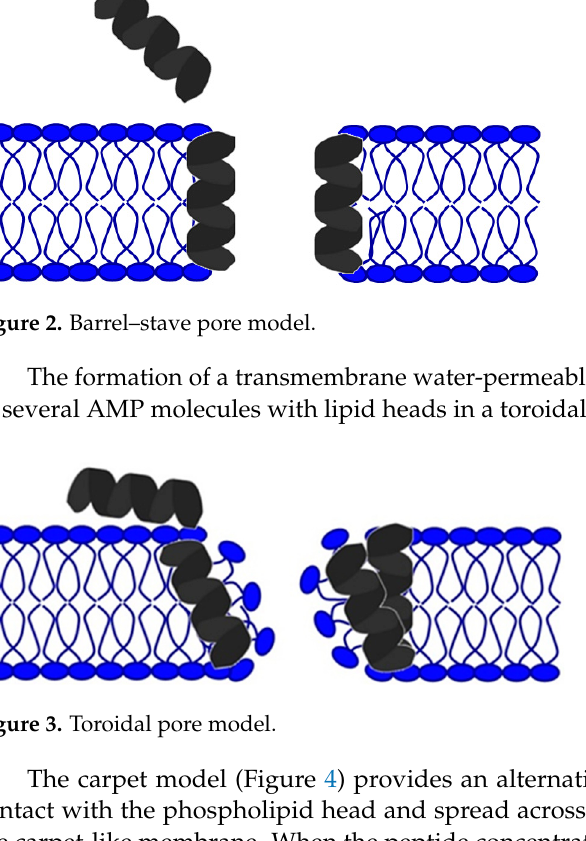
Figure 4. Carpet model. 3. Antimicrobial Effects of AMPs 3.1. Antibacterial Activity of AMPs As the primary goal in researching AMPs was the fight against (increasingly re- sistant) bacteria, some scientists emphasize this need and call them antibacterial peptides (ABP) [34,35]. They can destroy bacteria by breaking the cell wall and membrane of the bacteria, intracellular action, through a combination of dual destruction mechanisms, and by acting on the bacterial biofilm [36,37]. By binding to lipid II, which is part of the pepti- doglycan molecule and an essential factor in cell wall synthesis, ABPs prevent cell wall formation. In addition to controlling its assembly, it can destroy the already-formed cell wall [37–40]. Acting on the membrane is possible in several ways. The barrel-shaped and toroidal pore models can be defined as transmembrane pore models. Vertical insertion of the peptide into the membrane while promoting peptide–peptide lateral interaction is typ- ical of the barrel-shaped pore model [37,41,42]. In the toroidal pore model, peptides are also vertically embedded in the membrane. However, here the pores are created by both peptide and lipid groups. The most crucial difference between these two models is that the barrel model’s hydrophobic and hydrophilic bilayers remained intact [37,42,43]. The model that does not create pores through the membrane and in which specific peptide– peptide interactions are not necessary belongs to the so-called carpet model. It is charac- terized by adherence of ABP along the bacterial membrane and its adsorption until a par- ticular concentration is reached. After crossing the tolerance threshold, a detergent-like model appears, and a loss of integrity and opening of the bacterial membrane happens [13,37,43–45]. Many peptides work by destroying intracellular functions, and in that way, they kill bacteria. Some important ones inhibit DNA, RNA, and protein synthesis [42,46– 48]. The development of research and the discovery of peptides with antimicrobial effects show that specific peptides do not have only one impact model (Figure 5). On the contrary, most of them share a combination of mechanisms [37,42,43,49,50].